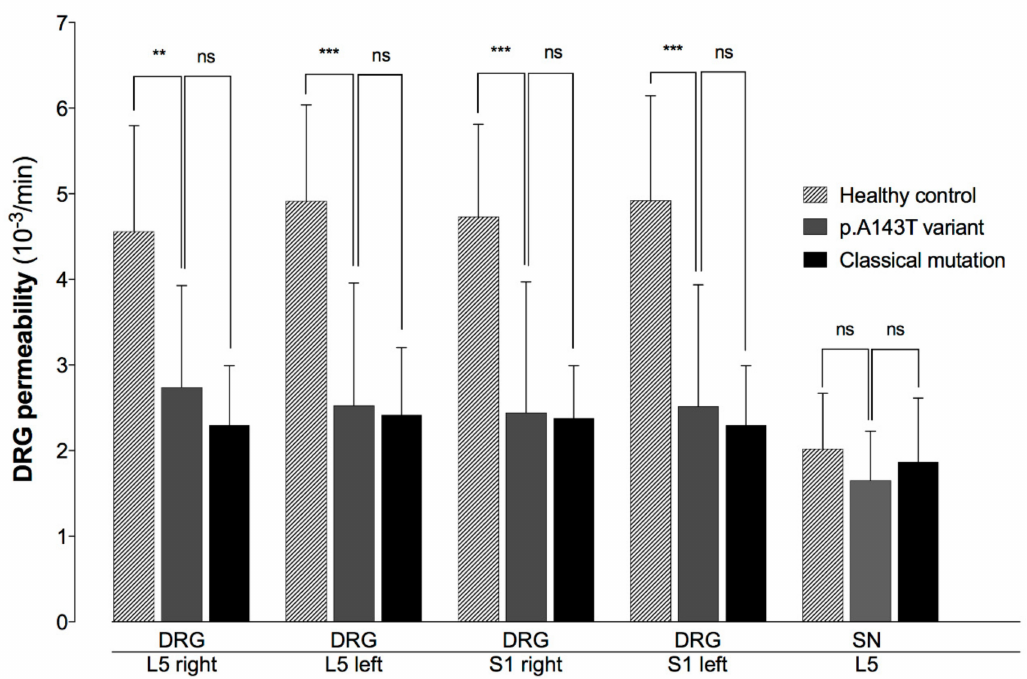
Figure 2. Permeability (K trans ) of the dorsal root ganglia (DRG) L5, S1 and spinal nerve (SN) L5. K trans as a marker of vascular permeability was assessed in p.A143T patients in comparison to patients with a classical Fabry mutation and healthy controls. Compared to healthy controls, p.A143T carriers showed decreased permeability for all DRGs, but non-significant less decreased compared to patients carrying a classical Fabry mutation. Spinal nerve L5, as internal reference, showed no di ff erences between p.A143T carriers, patients with a classical Fabry mutation, and healthy controls. (ns non-significant, ** p < 0.01, *** p <